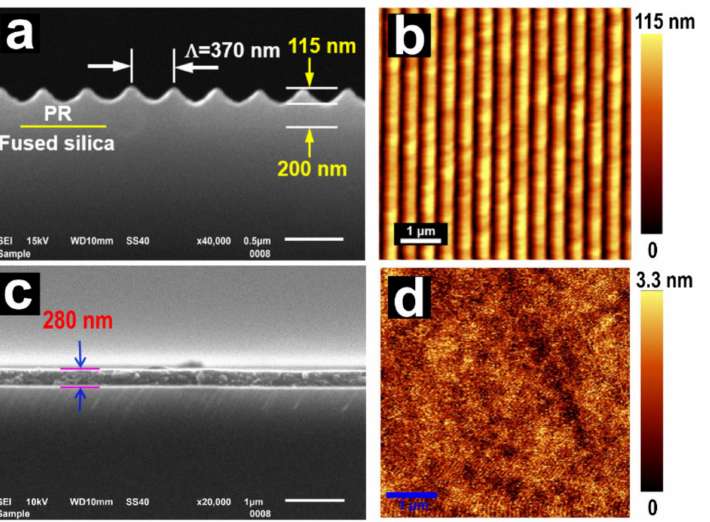
Figure 2. ( a ) SEM image of the cross-sectional profile of the photoresist grating structures. ( b ) AFM image measured on the top surface of the photoresist grating. ( c ) SEM image of the cross-sectional profile of the F8BT thin film, showing a thickness of about 280 nm. ( d ) AFM image measured on the top surface of the F8BT thin film, showing a variation amplitude of only 3.3